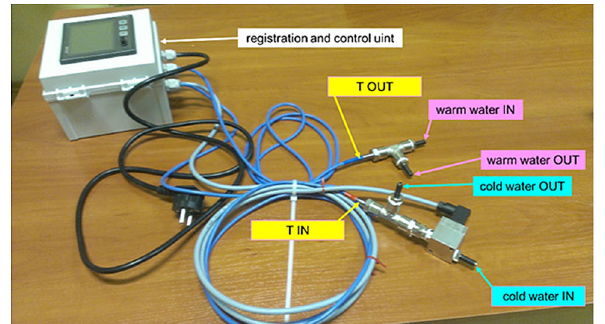
Figure 1. A water flow meter equipped with temperature sensors to monitor fluctuations of heat flux during therapy